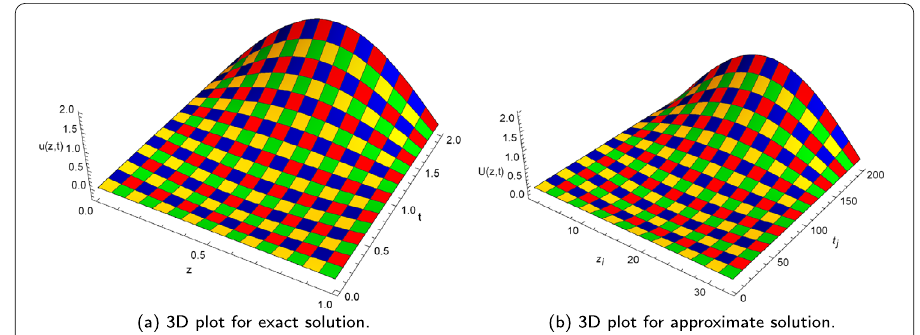
Figure 2 Exact and approximate solutions for Example 1, when N = 32, α = 1.5 and (cid:11) t = 0.01